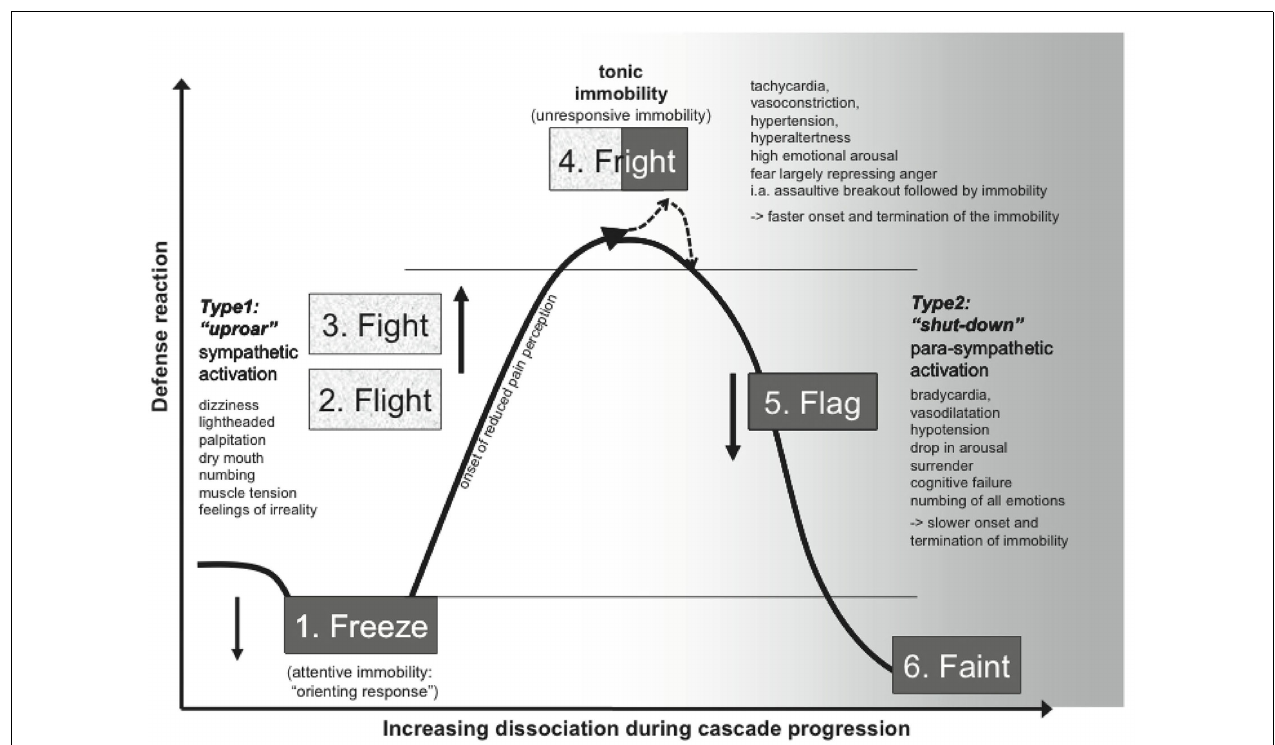
FIGURE 2 |Action and action tendency mapping in fear–trauma responding. Here, is provided an example of the complex non-linear relationship between bodily variables constitutive of the evolving action tendencies and the concomitant overt behaviors.Taken from Schauer and Elbert (2010). Reprinted with permission.